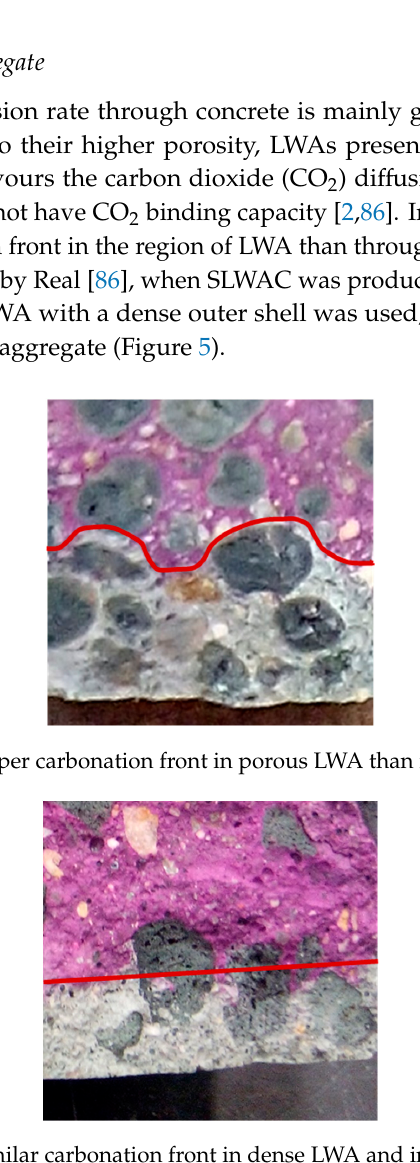
Figure 5. Similar carbonation front in dense LWA and in matrix [86].